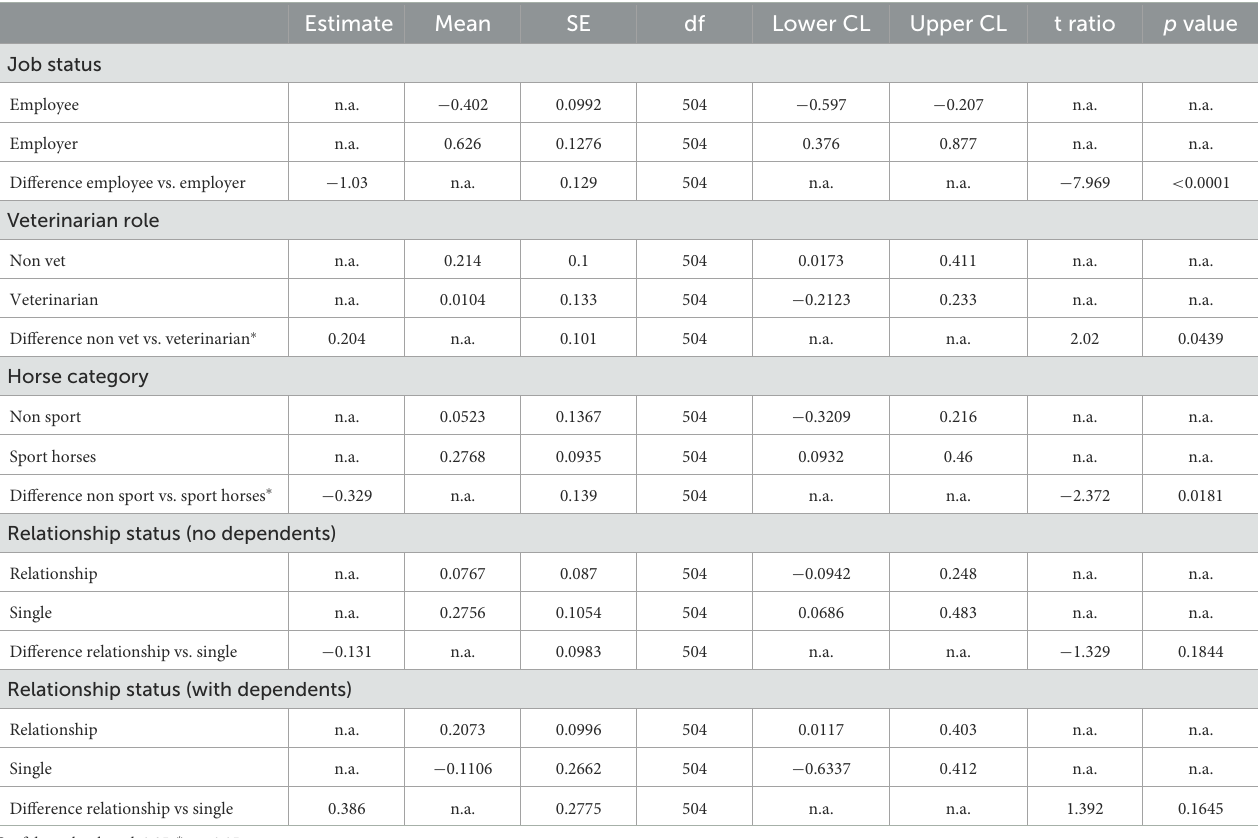
TABLE 3 Effect of factor “company culture and relationship with management” on overall work satisfaction for job status, veterinarian role, horse category and relationship status (with/without